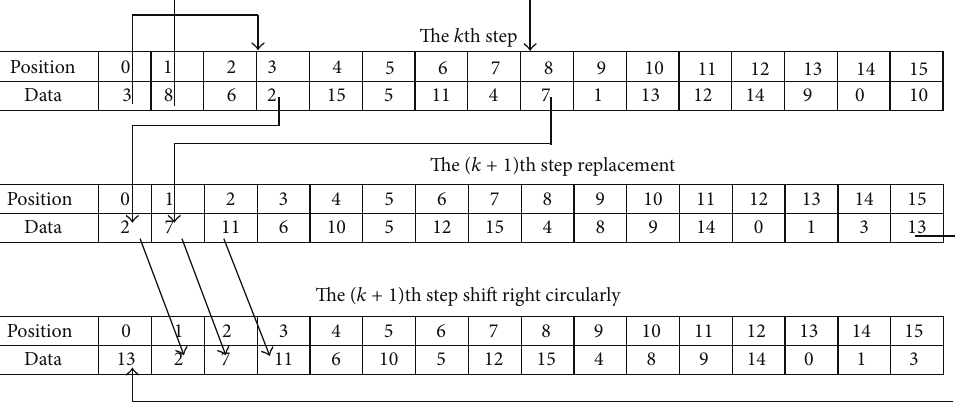
Figure 7: Data and position replacement